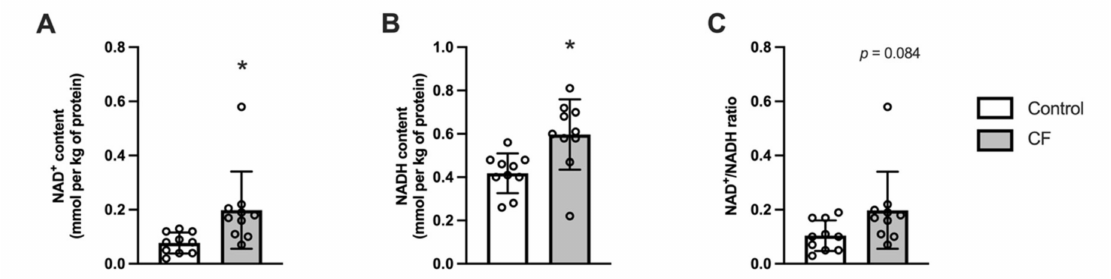
Figure 5. Fifteen days of supplementation modified NAD + metabolism in the white gastrocnemius in 129S1/SvlmJ mice. ( A ) NAD + content. ( B ) NADH content. ( C ) NAD + /NADH ratio. n = 10, means ± SD. * p < 0.05 vs. the control